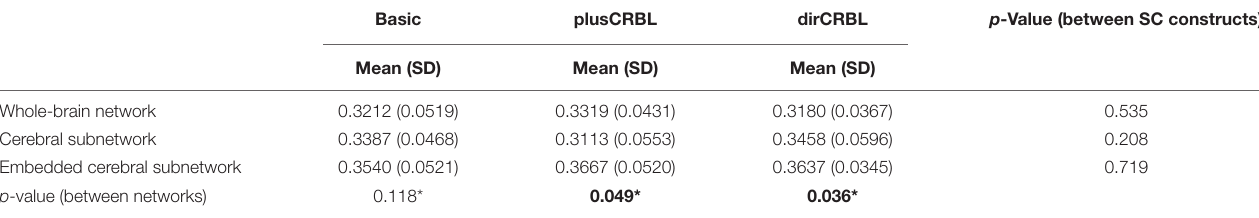
TABLE 3 | Pearson correlation coefficients between empirical and simulated